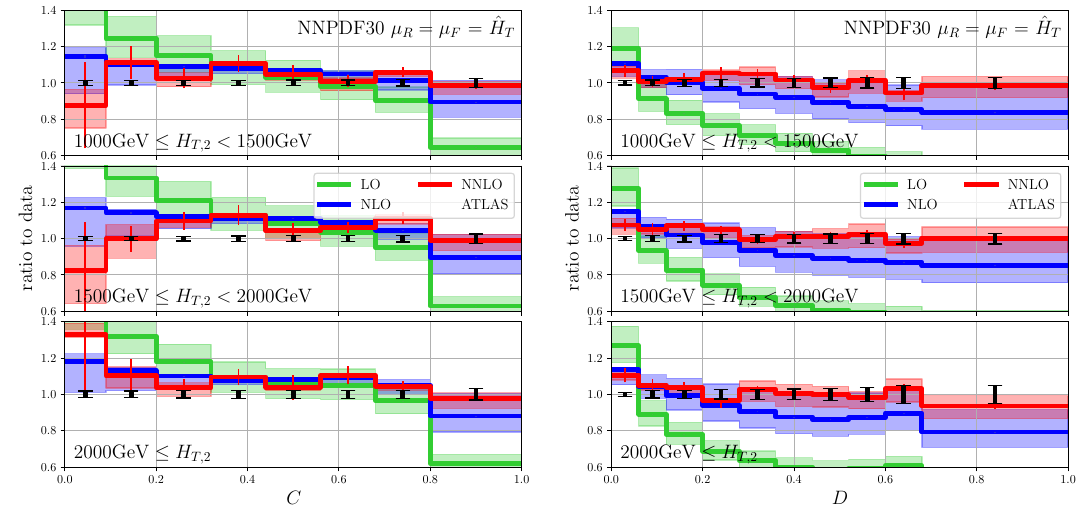
Figure 3 . As in figure 1 but for the variables C (left) and D